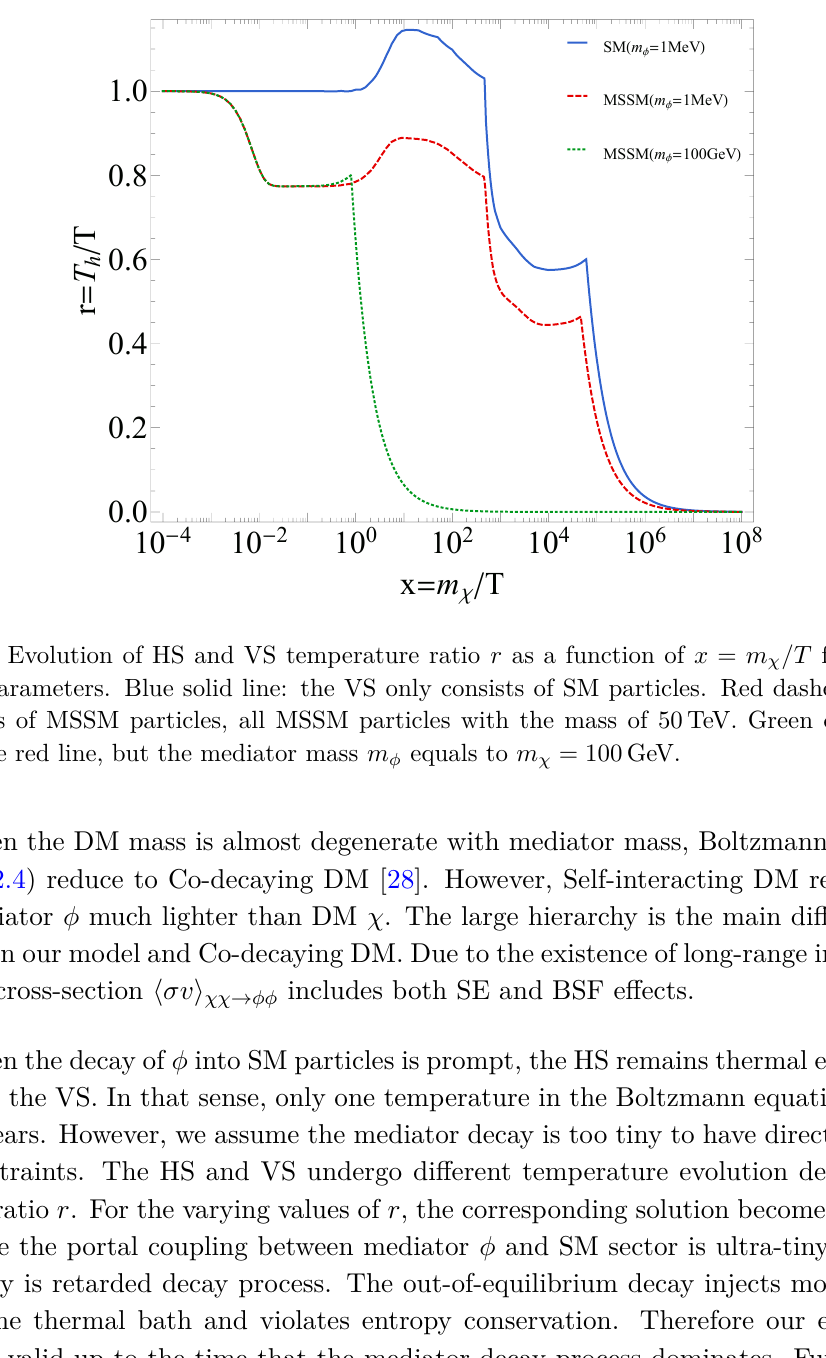
equals to m = 100 φ χ